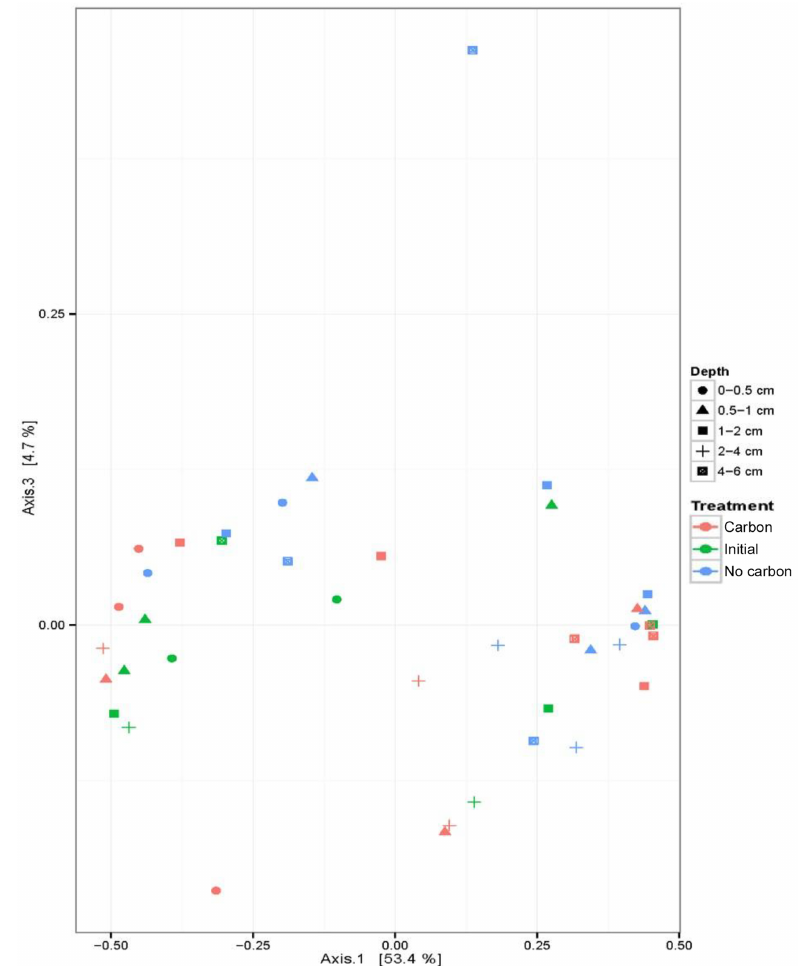
Figure 6. Principal component analysis ordination of the microbial community structure between the initial (In), + C and − C treatments at the five sediment depth intervals performed on a Bray–Curtis community dissimilarity